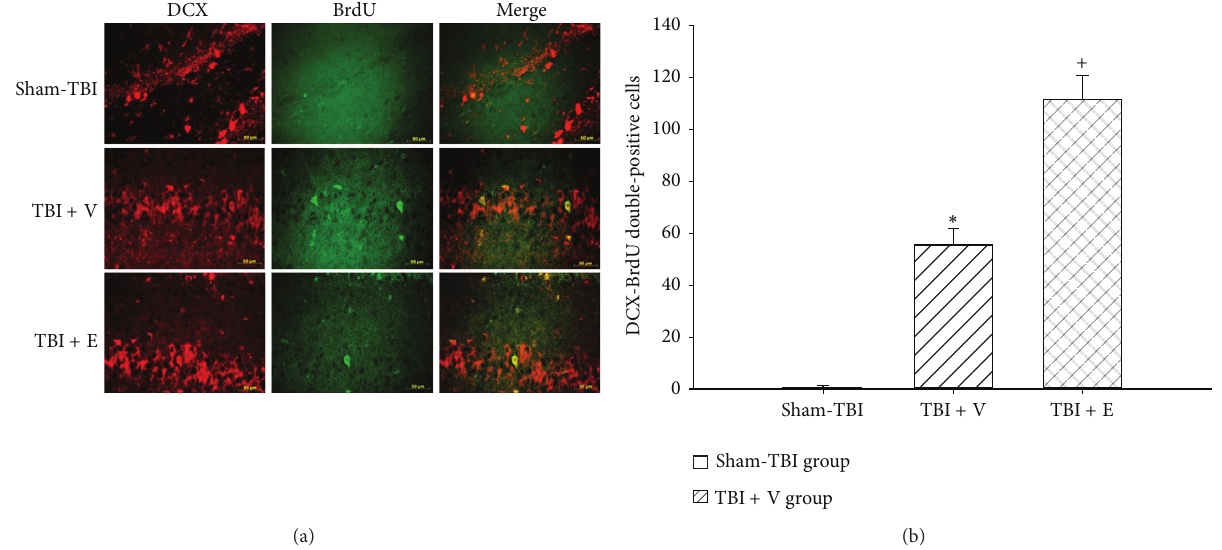
Figure 5: Mean ± standard deviation values of the number of BrdU-DCX-positive cells in the ischemic hippocampus. (See the legend of Figure 1 for group abbreviations). The data were obtained 7 days after TBI or sham-TBI operation ( 𝑛 = 8 ). ∗ 𝑃 < 0.05 compared with the sham-TBI group (white column); + 𝑃 < 0.05 compared with the TBI + V group (lined coumn). Right panels depict representative DCX-BrdU double stainings for one sham + E rat, one TBI + V rat, and one TBI + E rat.